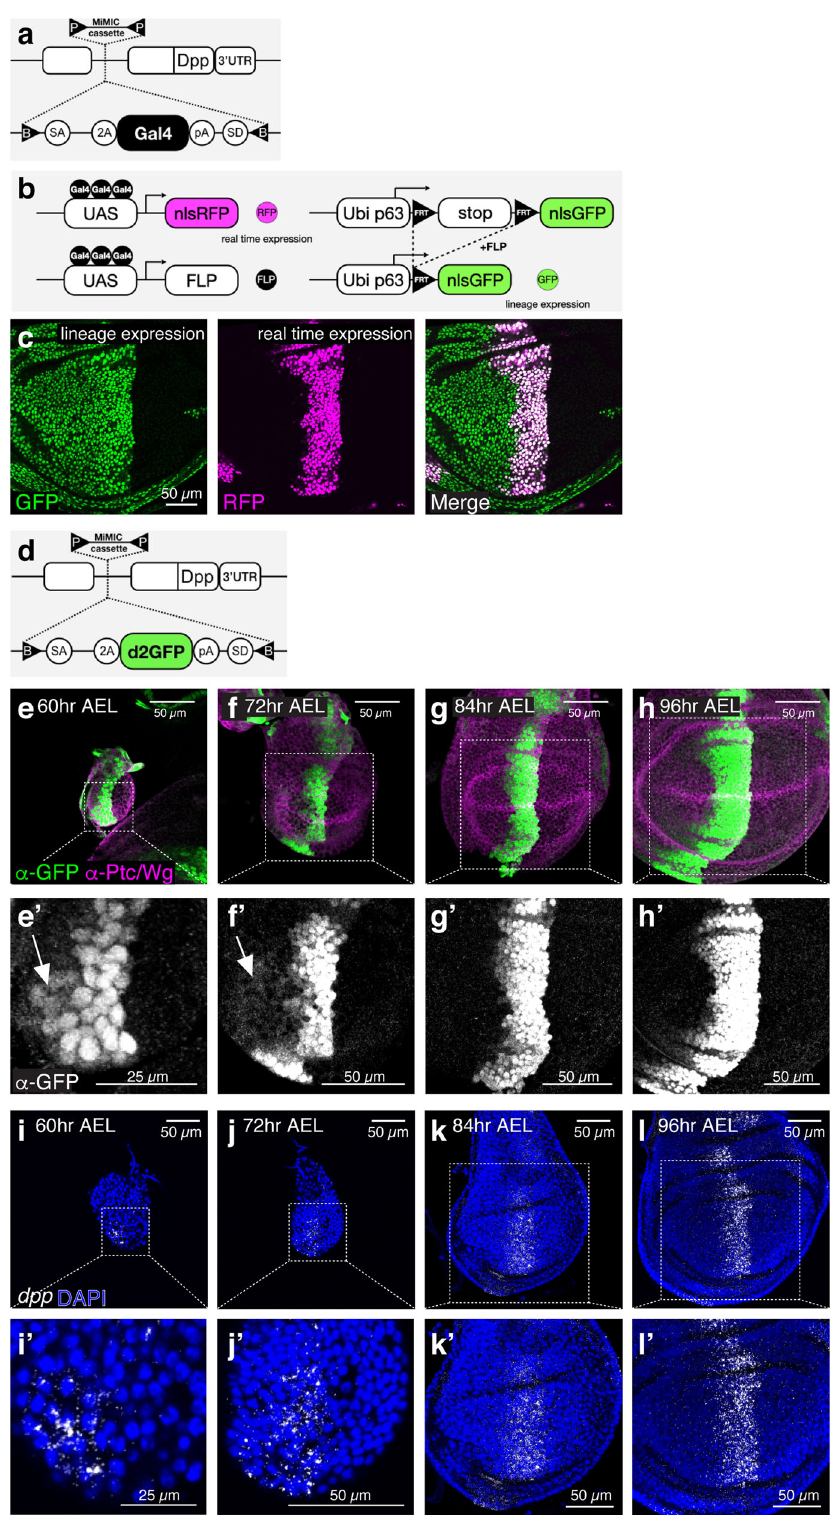
Fig. 7 Initial uniform dpp transcription in the anterior compartment. a A schematic view of a Gal4 insertion into the dpp locus. b A schematic view of G-TRACE analysis. While RFP expression labels the real-time Gal4 -expressing cells, GFP expression labels the lineage of the Gal4 -expressing cells. c G-TRACE analysis of the endogenous dpp-Gal4 . Scale bar 50 μ m. d A schematic view of d2GFP insertion into the dpp locus. e − h α -GFP and α -Ptc/Wg staining of wing disc expressing the d2GFP reporter at mid-second instar stage (60 h AEL) ( e ), at early third instar stage (72 h AEL) ( f ), at mid-third instar stage (84 h AEL) ( g ), and at mid- to late- third instar stage (96 h AEL) ( h ). e ʹ − h ʹ Magni fi ed wing discs from ( e − h ). Arrows indicate dpp transcription outside the stripe of cells. Scale bars as indicated. i − l smFISH against dpp using RNA scope technology. yw wing disc at 60 h AEL ( i ), 72 h AEL ( j ), 84 h AEL ( k ), 96 h AEL ( l ). i ʹ − l ʹ Magni fi ed wing discs from ( i − l ). Scale bars as indicated.